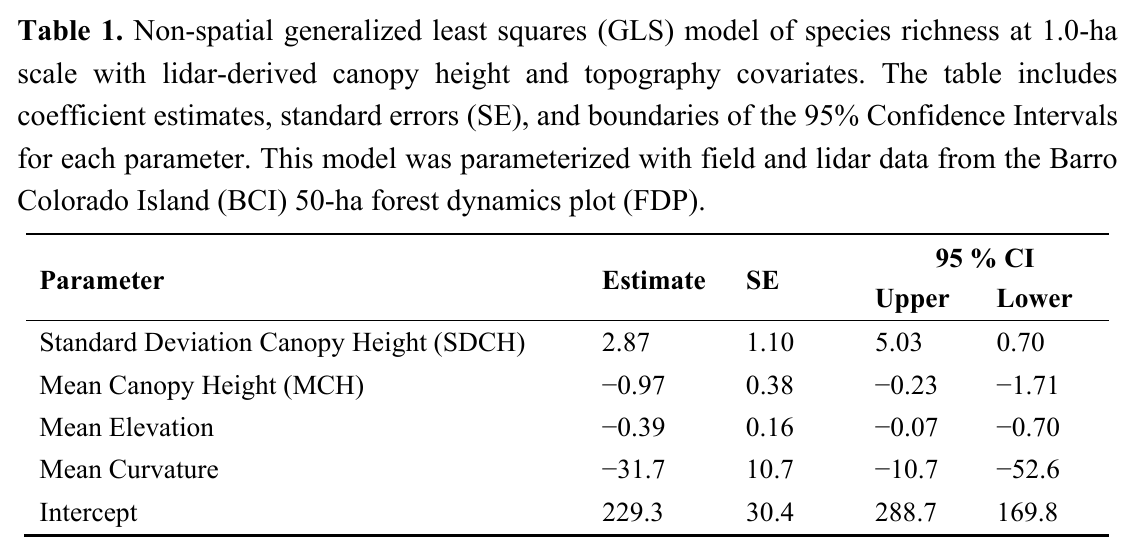
95 % CI Upper Lower